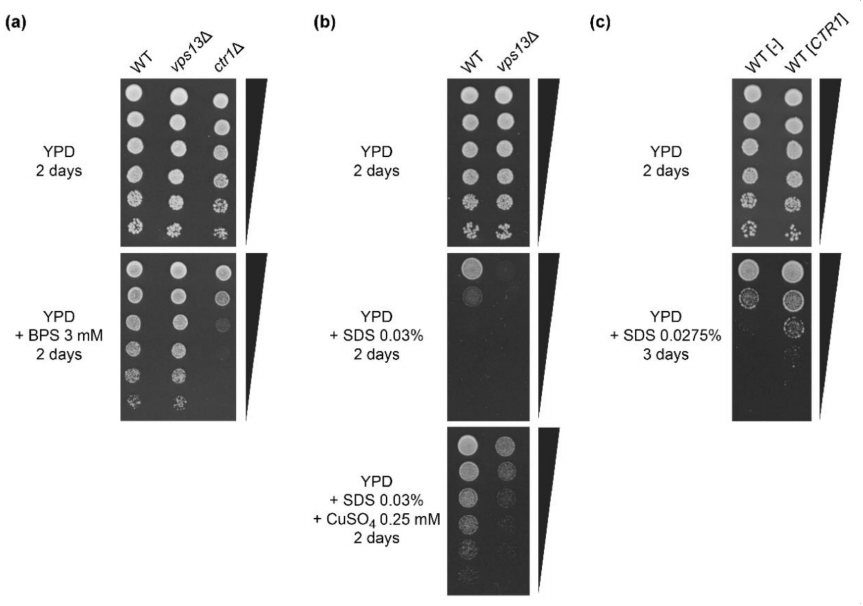
Figure A1. The vps13 ∆ is not sensitive to bathocuproinedisulfonic acid disodium salt (BPS) and copper-based suppression is not specific to vps13 ∆ . ( a ) Growth of wild type, vps13 ∆ and ctr1 ∆ strains was compared by a drop test on plates with YPD and YPD + BPS media. ( b ) Growth of wild type and vps13 ∆ strains was compared by a drop test on plates with YPD, YPD + SDS and YPD + SDS + CuSO 4 media. ( c ) Impact of CTR1 overexpression on wild type cells growth was investigated by a drop test on plates with YPD and YPD + SDS